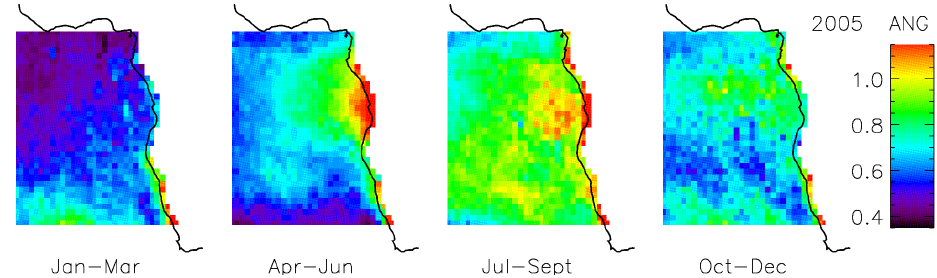
Fig. 4. Maps of seasonally averaged measurements of Angstrom exponent (ANG), for 2005.